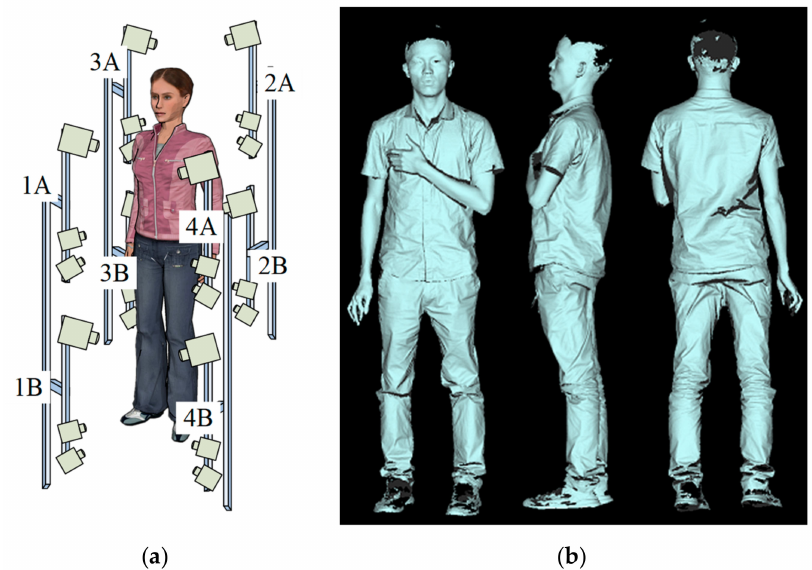
Figure 9. ( a ) Sketch of the measurement network; ( b ) reconstruction result of human